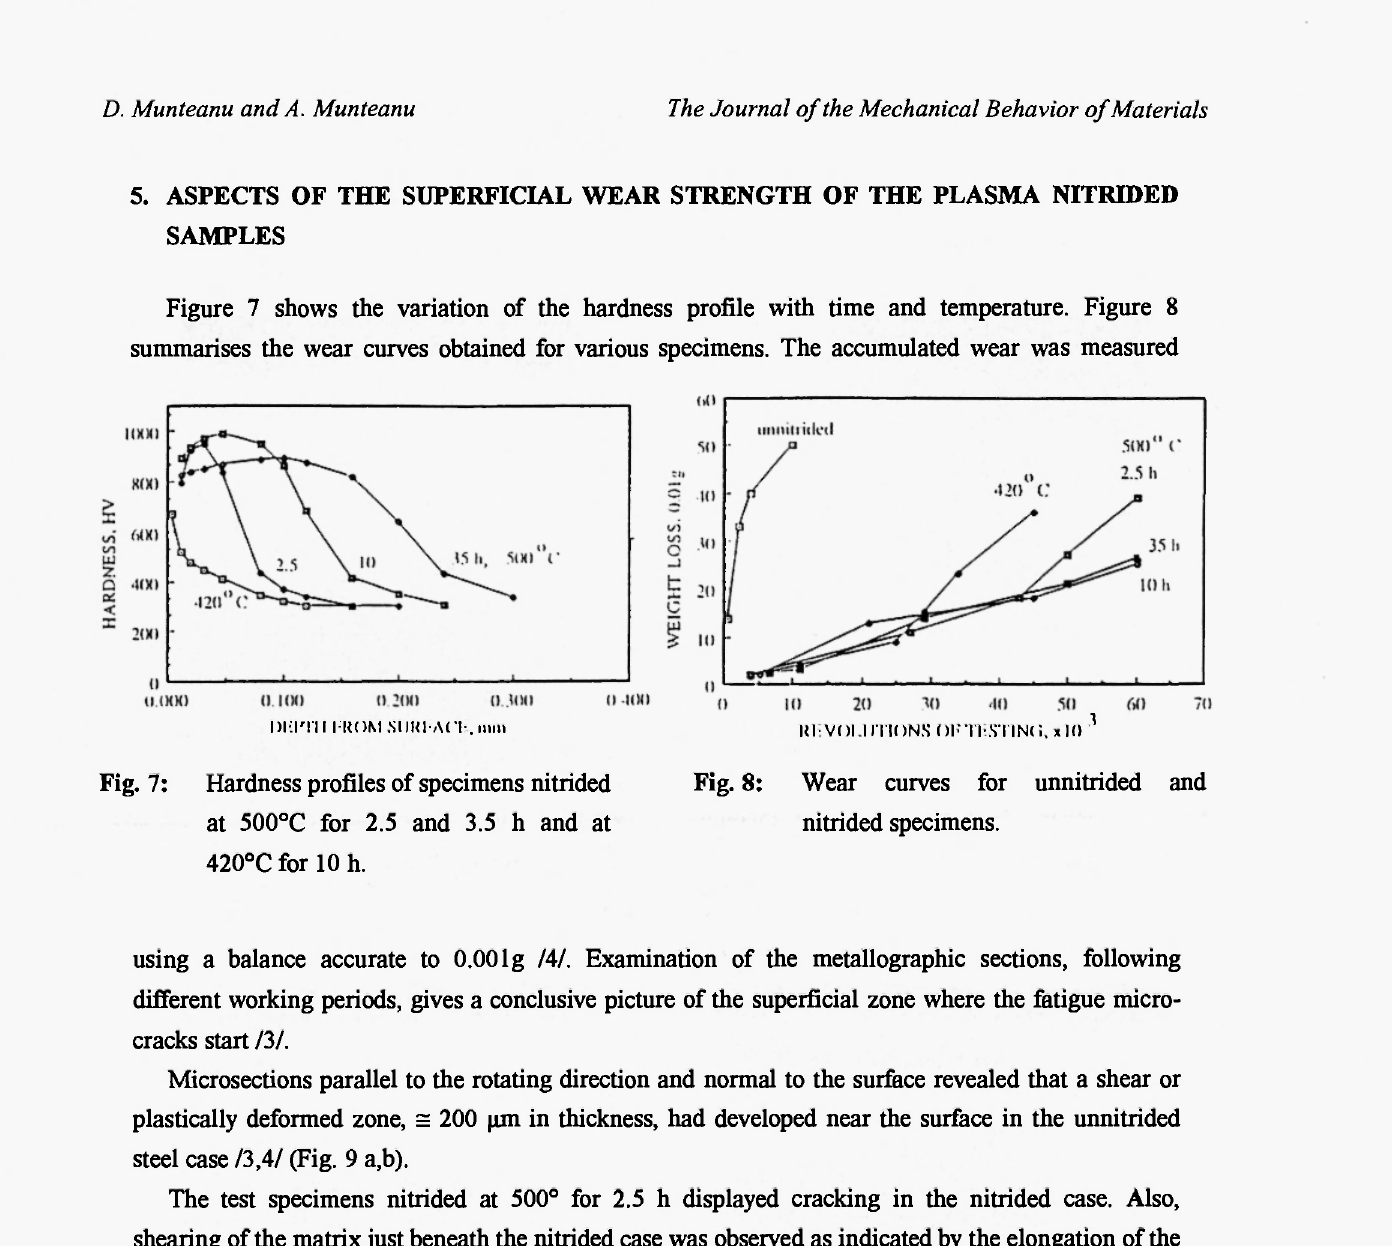
Fig. 7: Hardness profiles of specimens nitrided Fig. 8: Wear curves for unnitrided and at 500°C for 2.5 and 3.5 h and at nitrided specimens. 420°C for 10